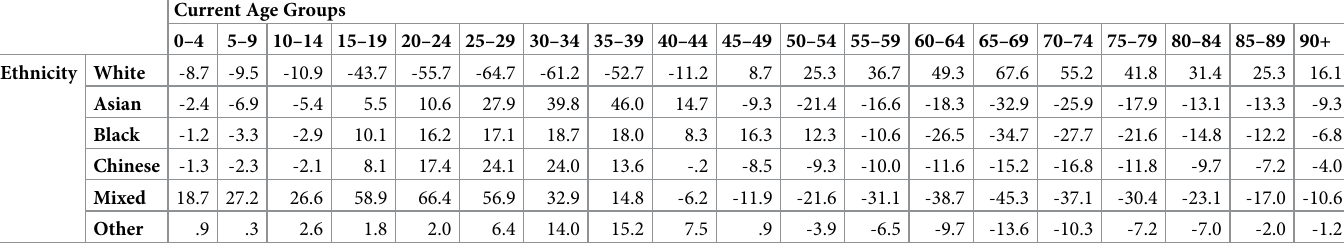
Table 9. Chi 2 test of independence adjusted residuals for ethnicity and current age group (analysed using dataset 2 –April 2015). Current Age Groups Ethnicity